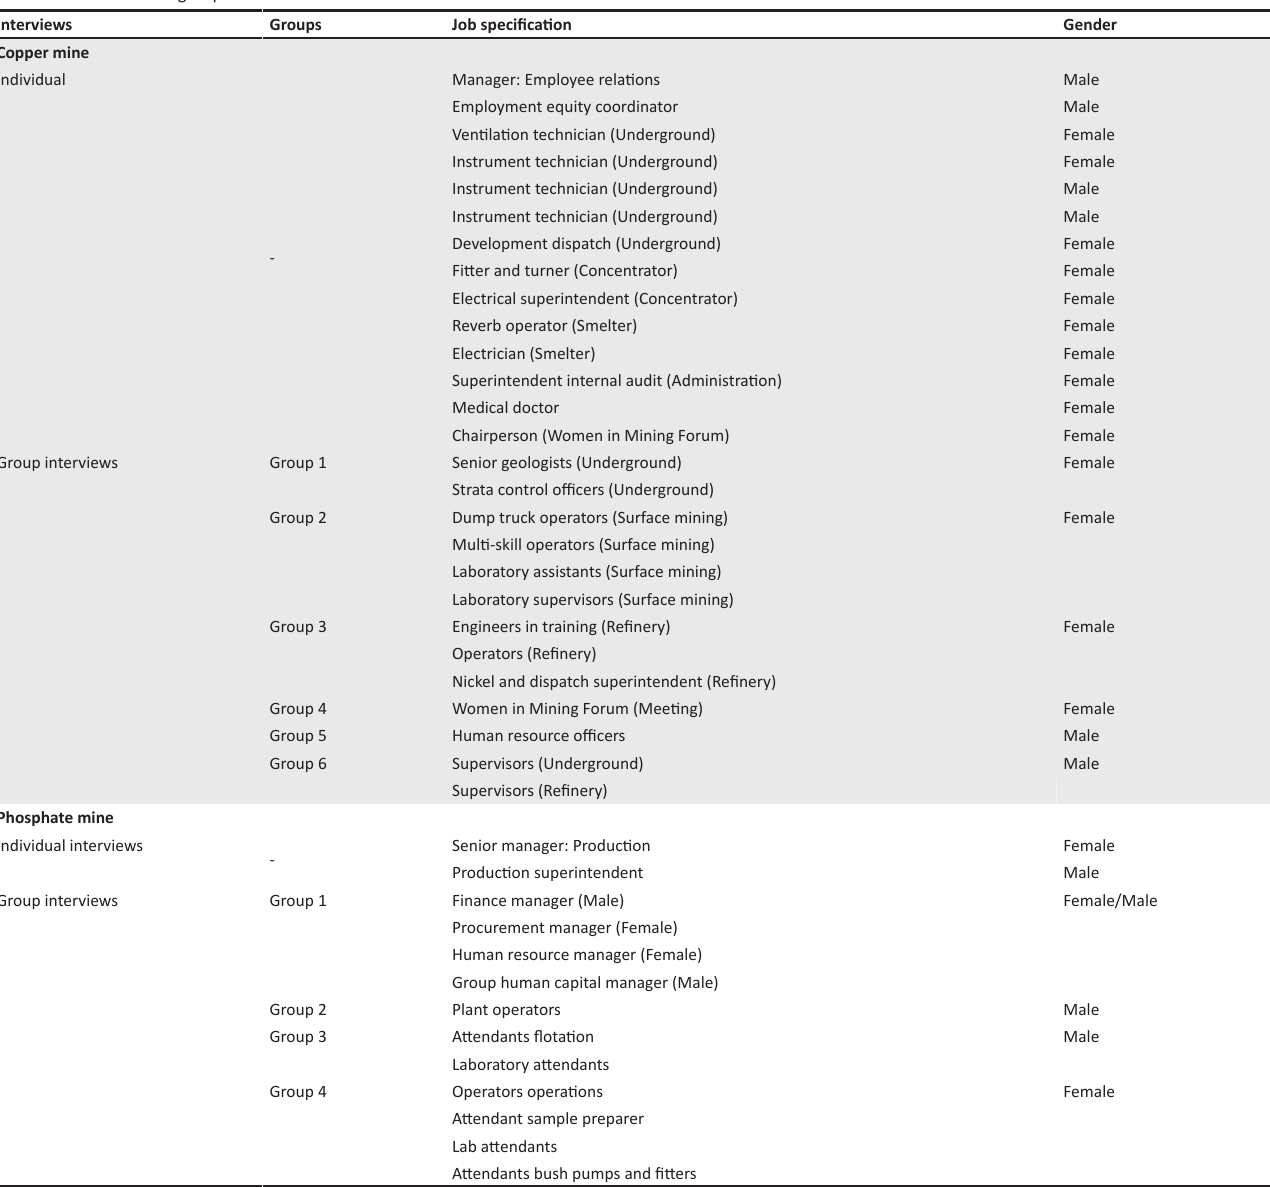
TABLE 2: Individual and group interviews conducted at the